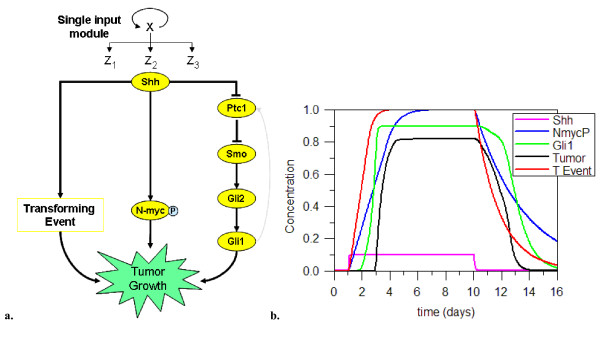
Shh activates three separate pathways in this model, each with a different activation and decay threshold and rate. a. A single input motif in the hedgehog pathway is highlighted. b. Simulation reveals that the unknown "transforming" event activates immediately when the Shh signal reaches a high level. NmycP production is also activated immediately by Shh, but it rises more slowly. Gli1 production is delayed by the longer signaling chain and threshold levels of Smo and Gli2 that are required for transcription. Tumor growth requires activation of all three pathways at a sufficient level. When the Shh signal is removed, rapid decay of the transforming event and NmycP cause tumor growth to quickly stop. Gli1 levels are maintained for a short delay before declining after the Shh signal is turned off.